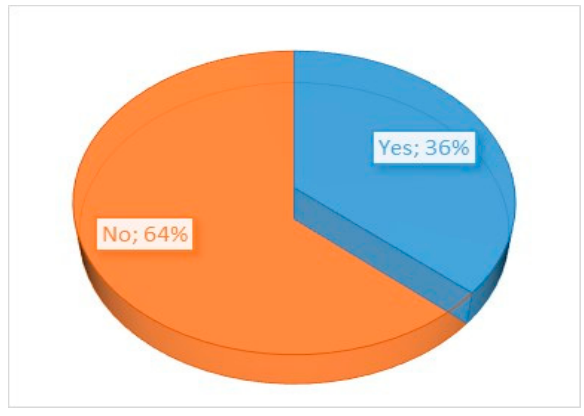
Figure 9. The use of IT systems (CRM, CAM, CAD, etc.).